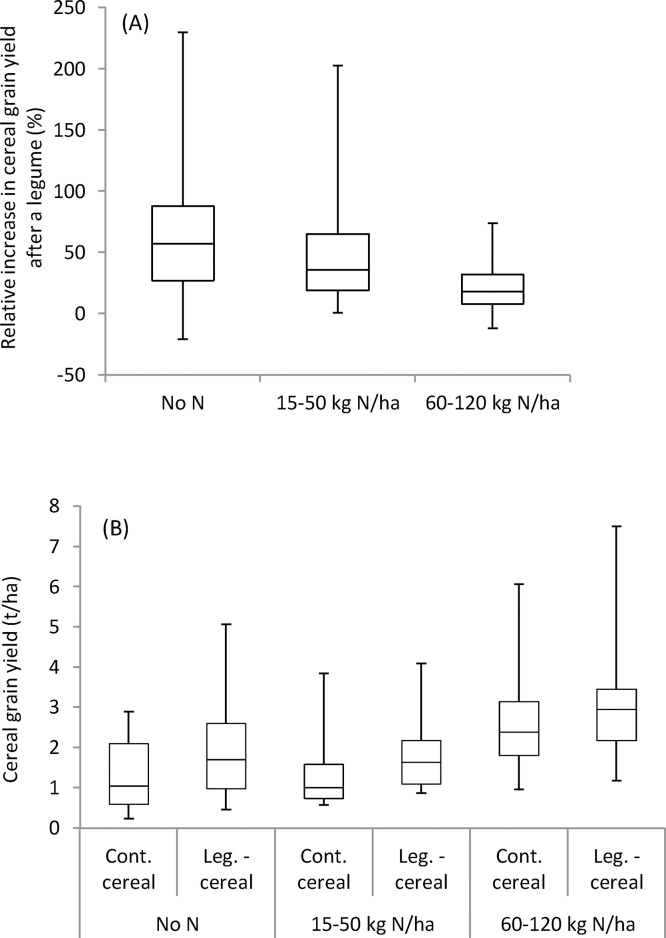
Box plots of (A) percentage grain yield increase of cereal after a legume crop, relative to the yield in continuous cereal, and (B) cereal grain yield in continuous (cont.) cereal and legume (leg.)-cereal rotations, at different N application rates to cereals. The whiskers represent the 2nd and 98th percentile of the observations.